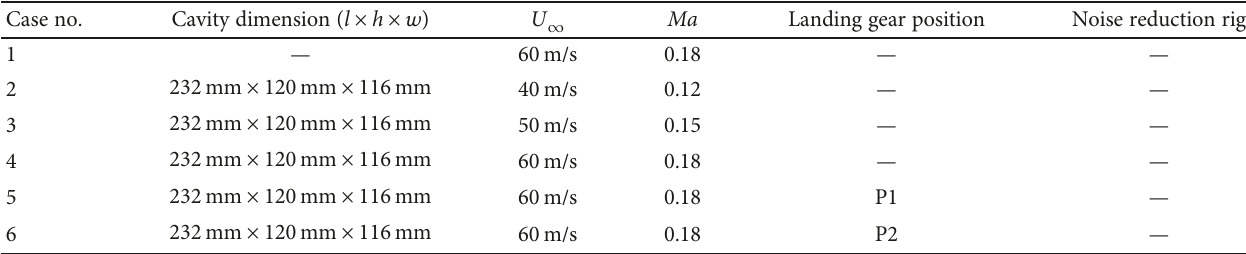
Table 1: Test matrix.